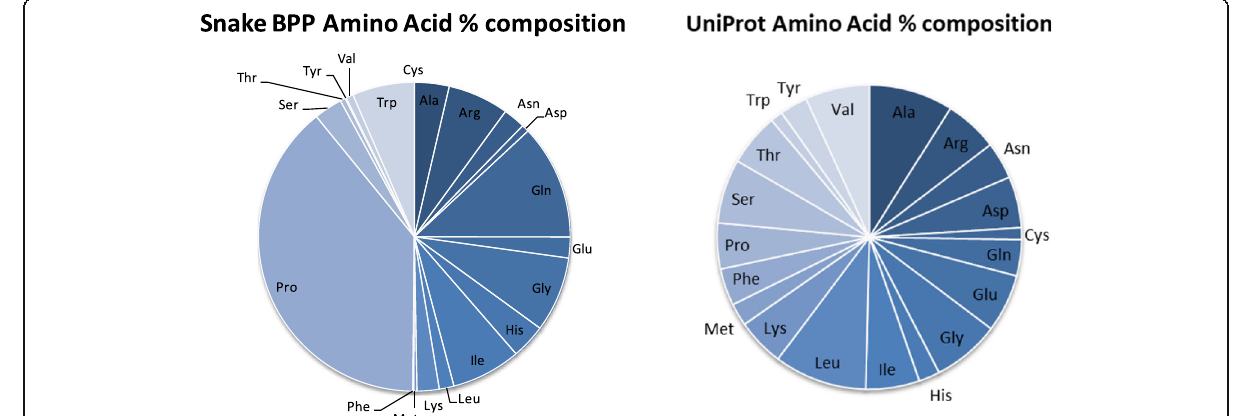
Fig. 2 Amino acid percent composition of the samples